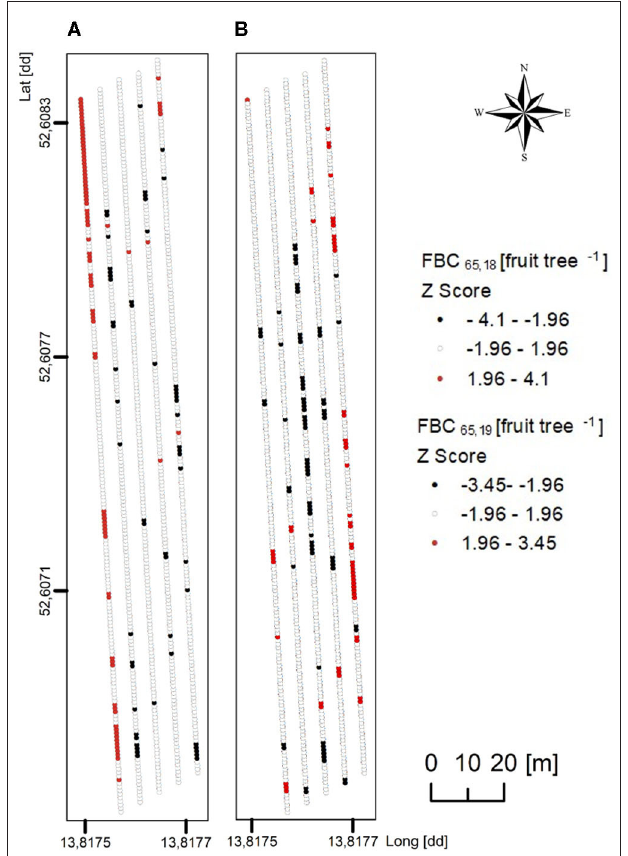
FIGURE 9 | Maps of z -scores in Getis–Ord’s analysis applied to FBC for the mean fruit diameter of 65mm (FBC 65 ), considering 996 trees of ‘Gala’/M.9 per year in (A) 2018 and (B) 2019. Red indicates significant spatial clusters of high values (a hot spot), black indicates significant spatial clusters of low values (a cold spot), and white indicates random distribution with no spatial clustering.